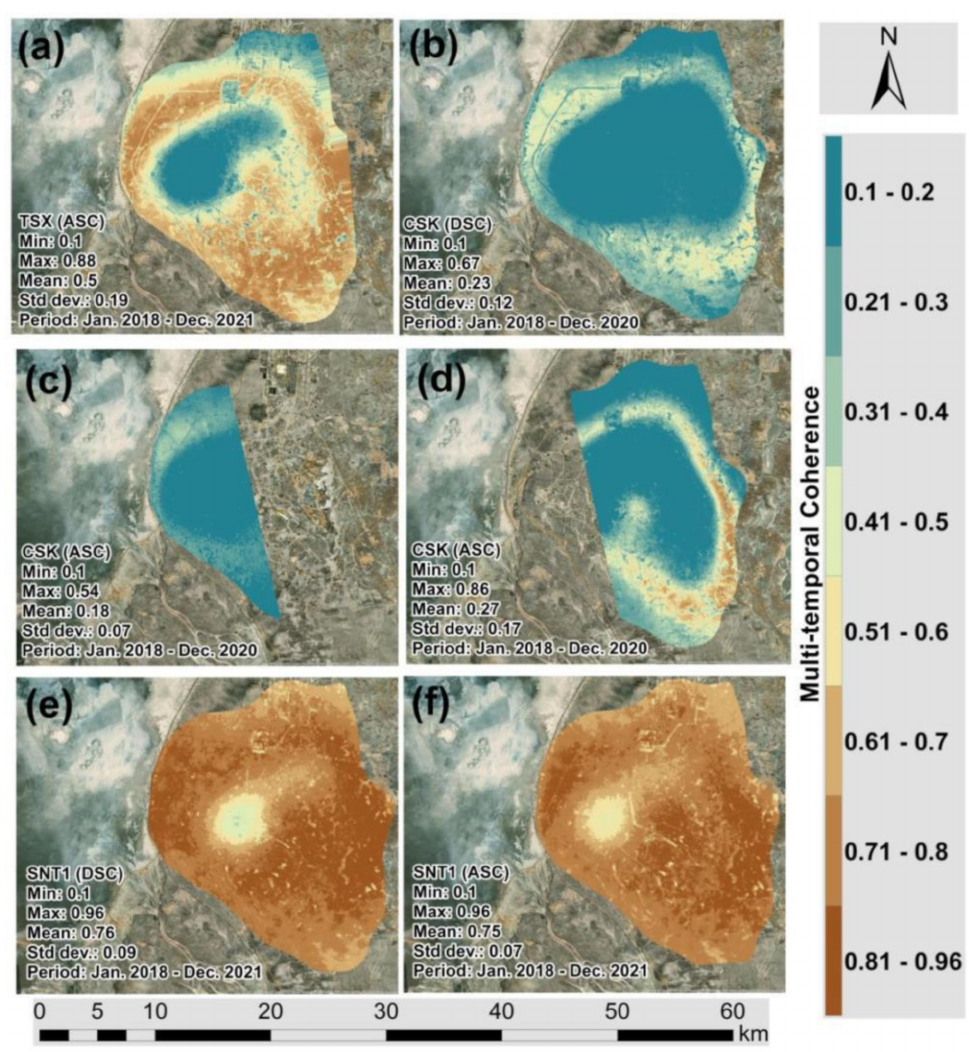
Figure 7. Multi-temporal coherence: ( a ) TSX (ASC Track); ( b ) CSK (DSC Track); ( c ) CSK (ASC Track 1); ( d ) CSK (ASC Track 2); ( e ) SNT1 (DSC Track); ( f ) SNT1 (ASC).